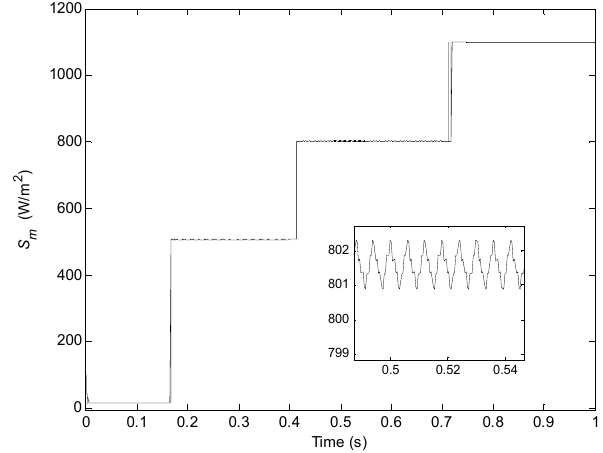
Figure 19. Curve in second simulation.